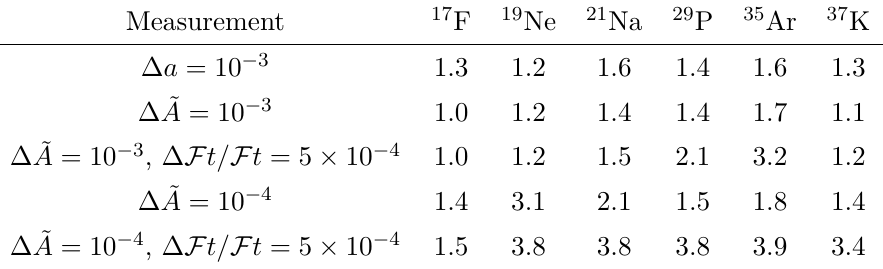
= 0 . 97424(95) . A given ud